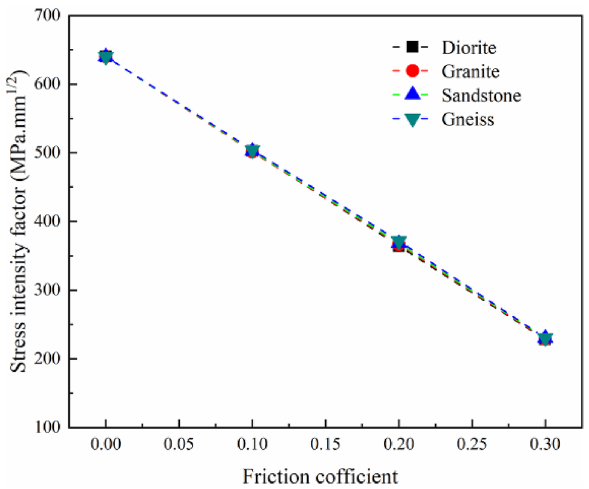
Figure 4. Variation of stress intensity factor with the elastic modulus of rock specimens under different friction